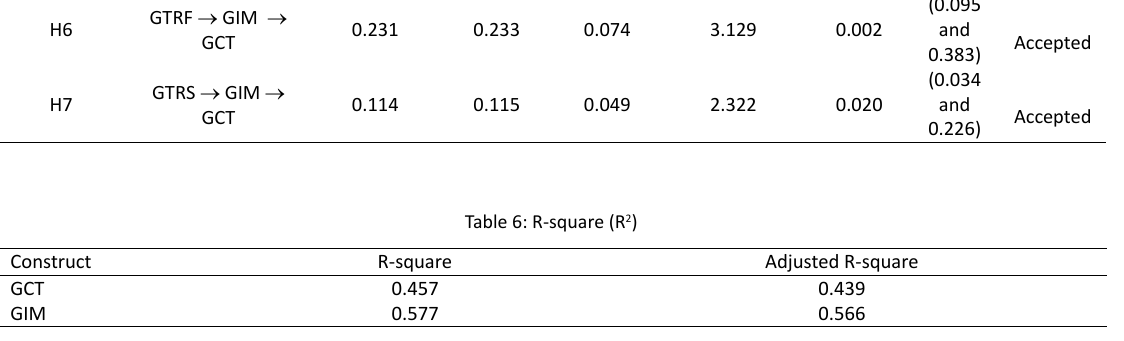
Table 5: Structural model assessment (indirect effect result and decision) Hypotheses